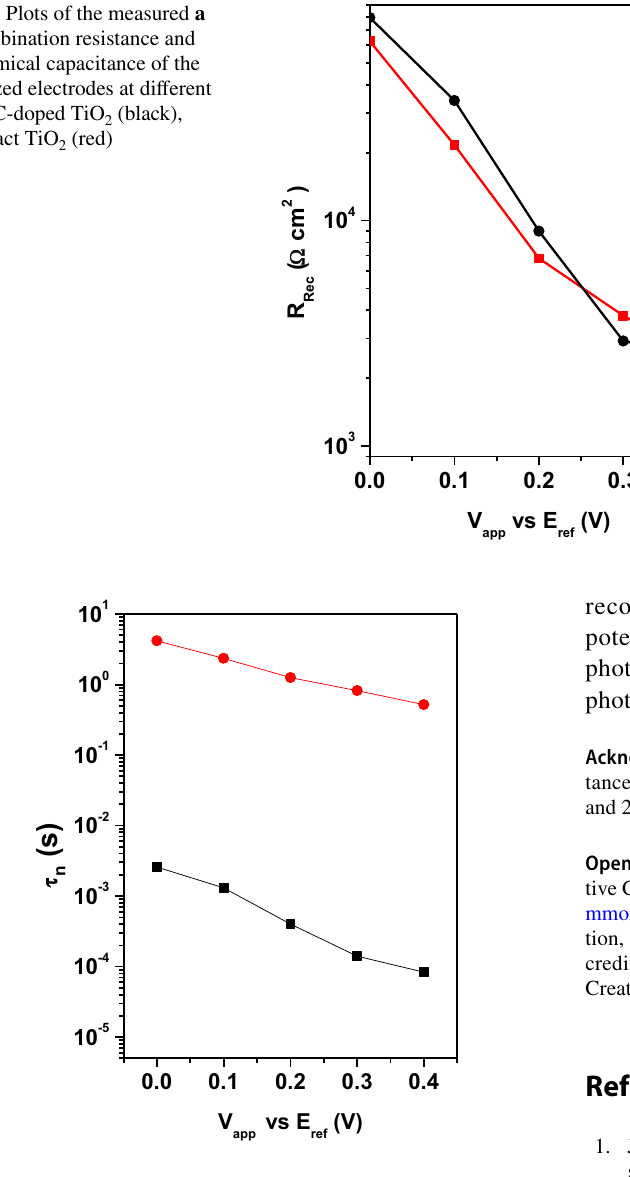
Fig. 7 Electron lifetime of the analyzed electrodes determined at dif- ferent